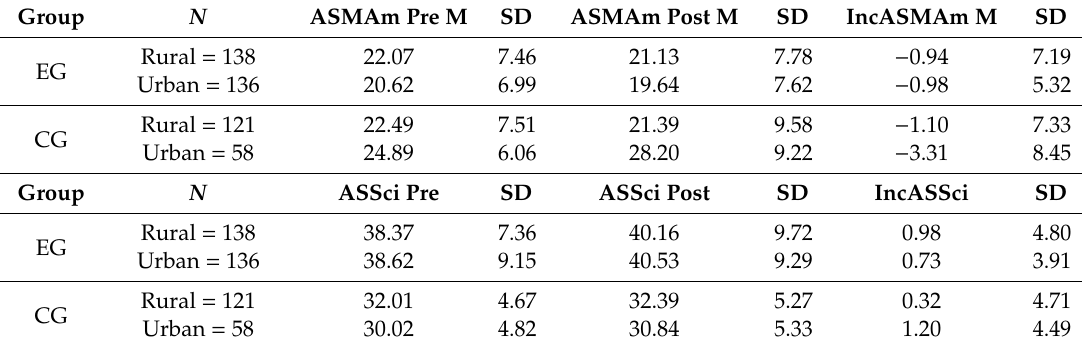
Table 6. Mean, M, and standard deviation, SD, of attitude towards mathematics and attitude towards school science for schools in rural ( N = 259) and urban settings ( N = 194), in the experimental and control group. The increment for each is shown in the third column, IncASMAm and IncASSci. ( N = 274 for EG; N = 179 for